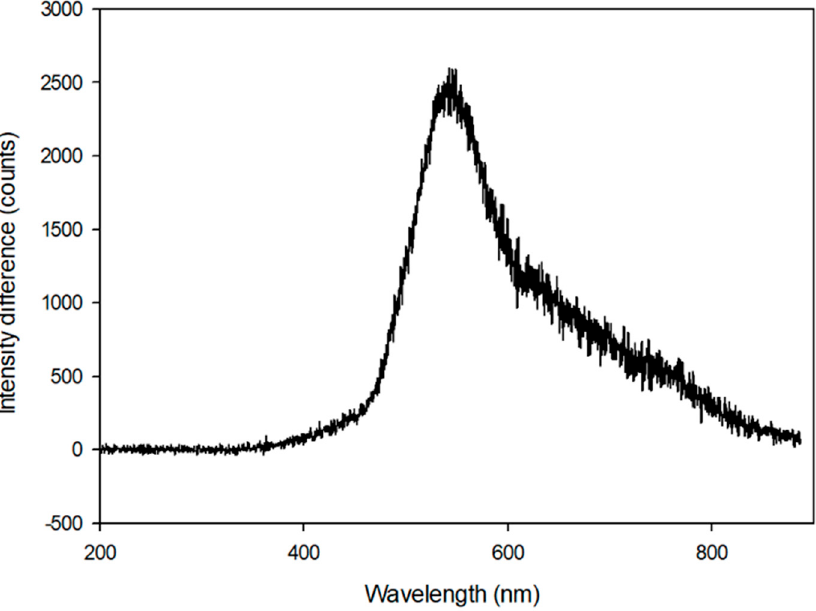
Figure 4. The spectrometric intensity difference between the light reflected from the test line (i.e., aggregate of gold labeled particles) area and the membrane background. The difference is greatest at a wavelength of 546 nm.